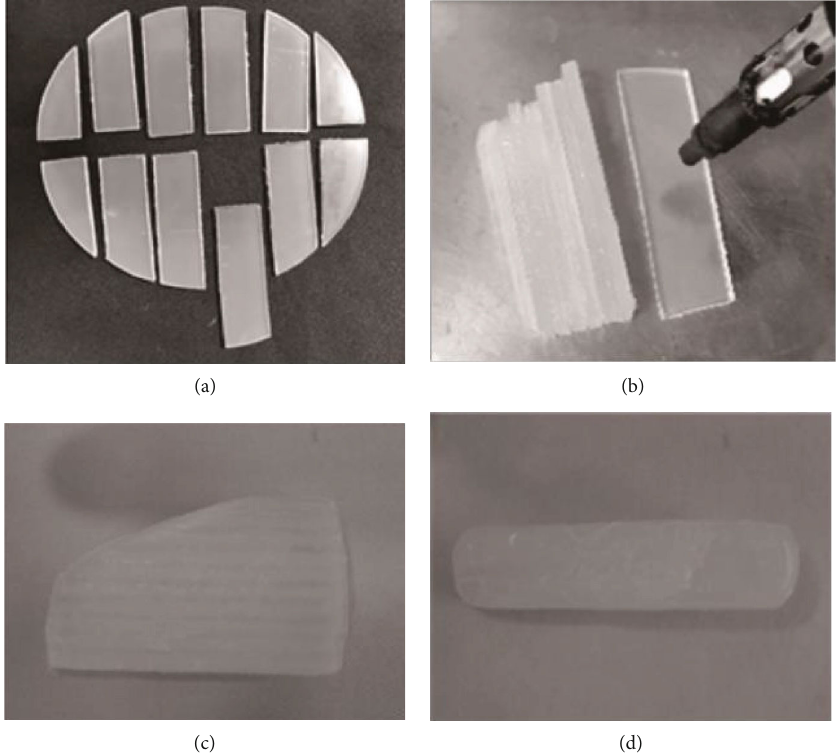
Figure 4: Fabrication of the device. (a) A 4mm thick ethylene vinyl acetate (EVA) sheet was cut into 2 × 6 cm pieces. (b) The surface of the sheets was softened using a burner, and blocks were created. (c) Lateral view of the device. (d) Top view of the